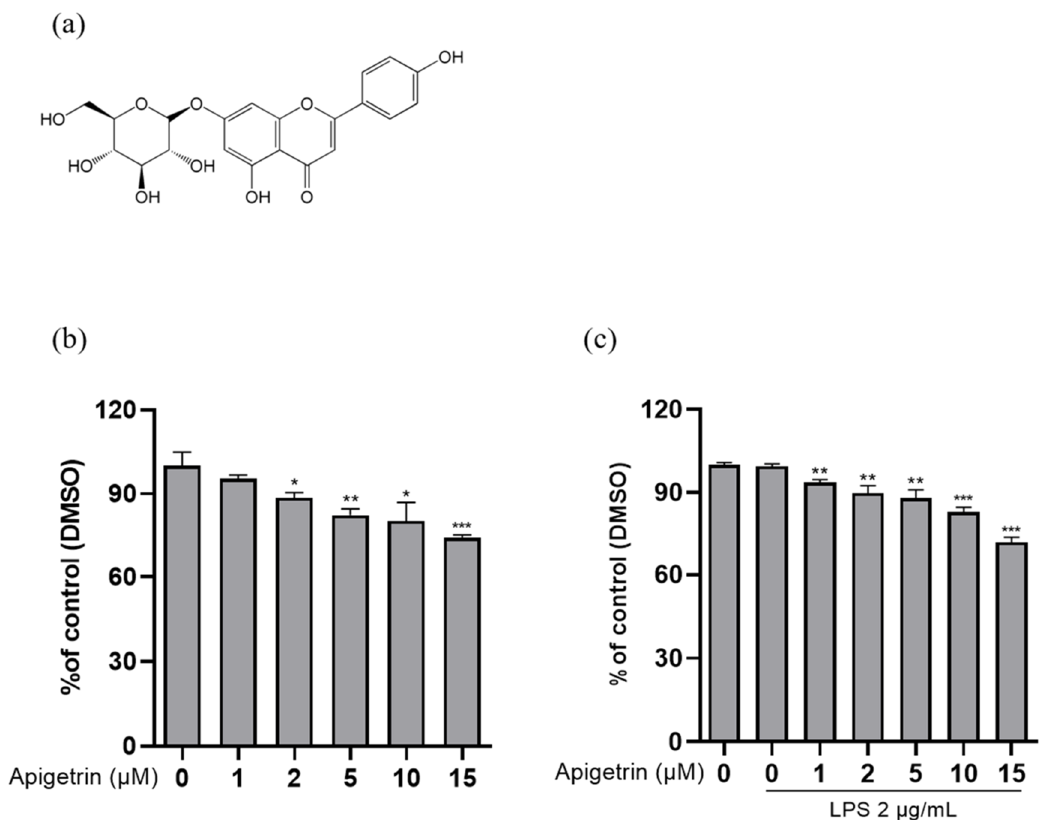
Figure 1. Cytotoxic effect of apigetrin in L6 cells. ( a ) The chemical structure of apigetrin. ( b ) L6 cells were treated with apigetrin (0, 1, 2, 5, 10, and 15 μM) for 24 h. ( c ) L6 cells were treated with apigetrin (0, 1, 2, 5, 10, and 15 μM), with or without LPS (2 μg/mL), for 24 h. The results are presented as the mean ± standard deviation (SD) of three independent experiments. * p < 0.05; ** p < 0.01; *** p < 0.001 vs. untreated group and the LPS-alone-treated group, respectively.